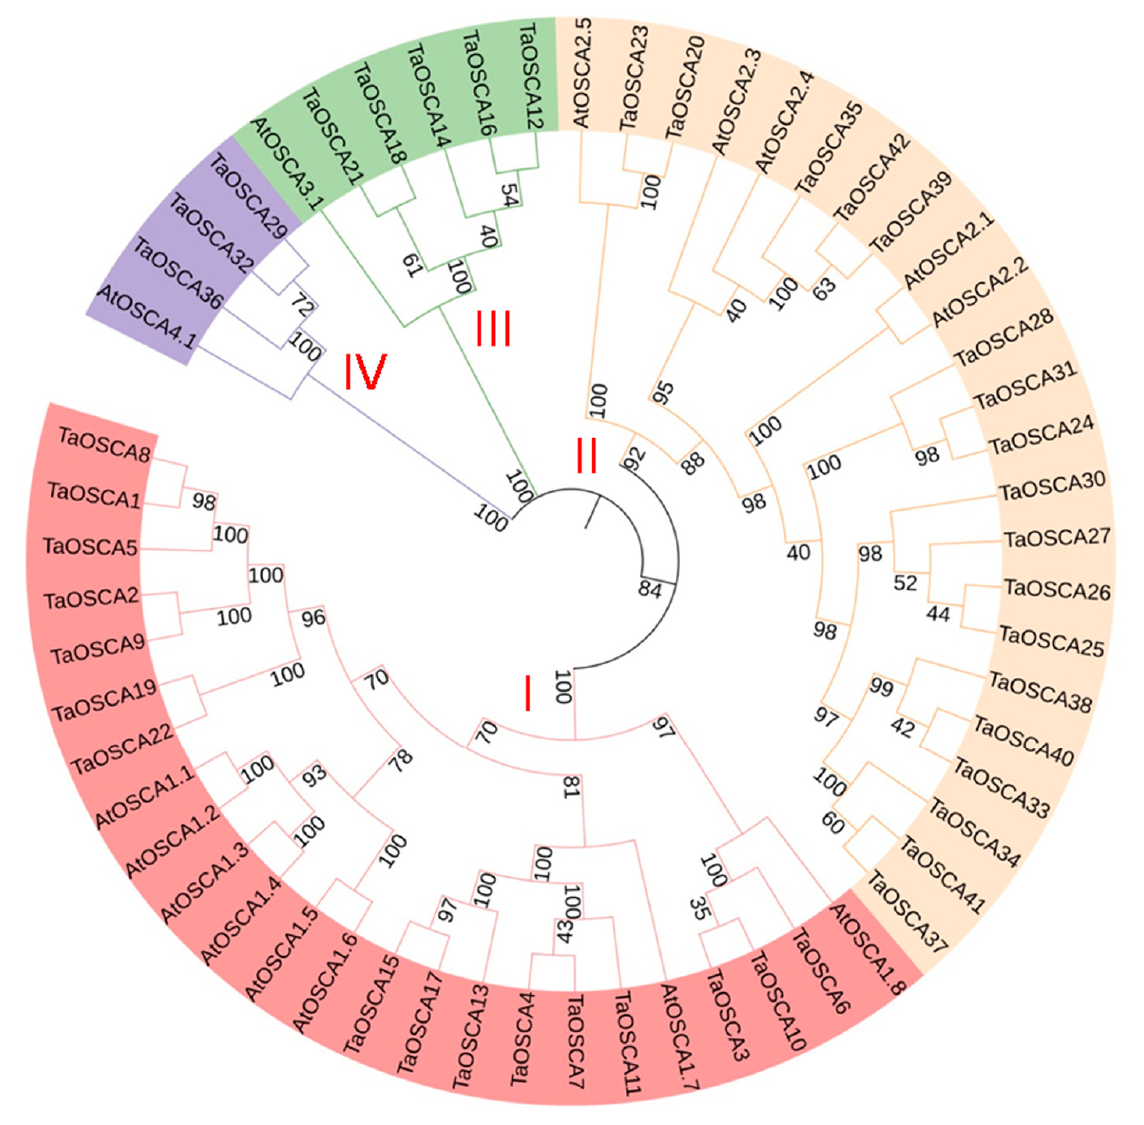
Figure 1. Phylogenetic tree of the OSCA proteins of Triticum aestivum and A. thaliana . The phylogenetic tree was constructed using OSCA amino acid sequences by the neighbor-joining method in MEGA X with 1000 bootstrap replicates. The phylogenetic tree is divided into four groups, which are shown in different colors, and identified by red Roman numerals.